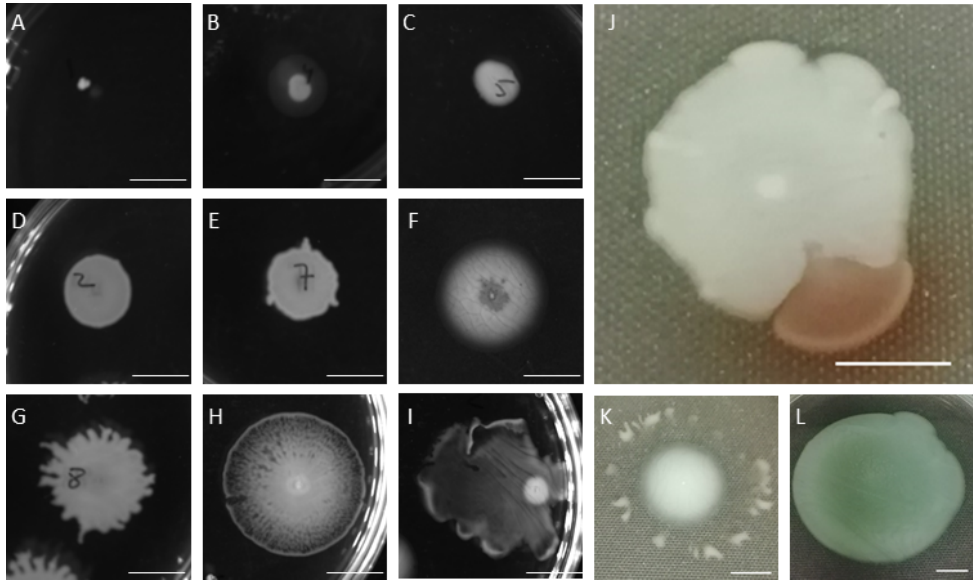
Figure 6. Different swimming motilities observed in surviving cells: ( A – I ) images acquired using Chemi XT4; and ( J – L ) digital photographs.